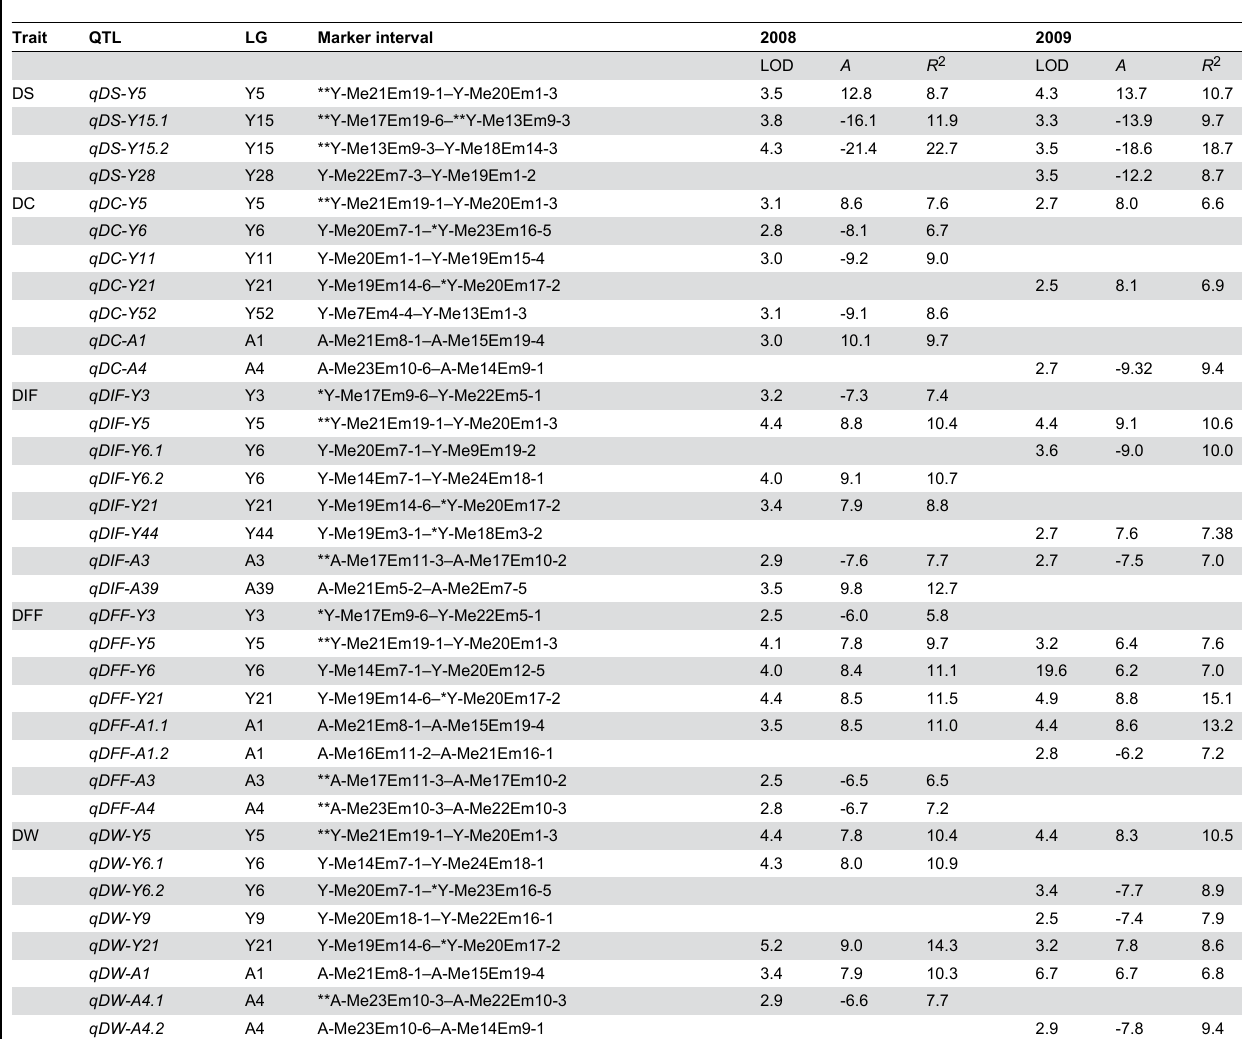
Table 3. Additive QTL for selected flowering time